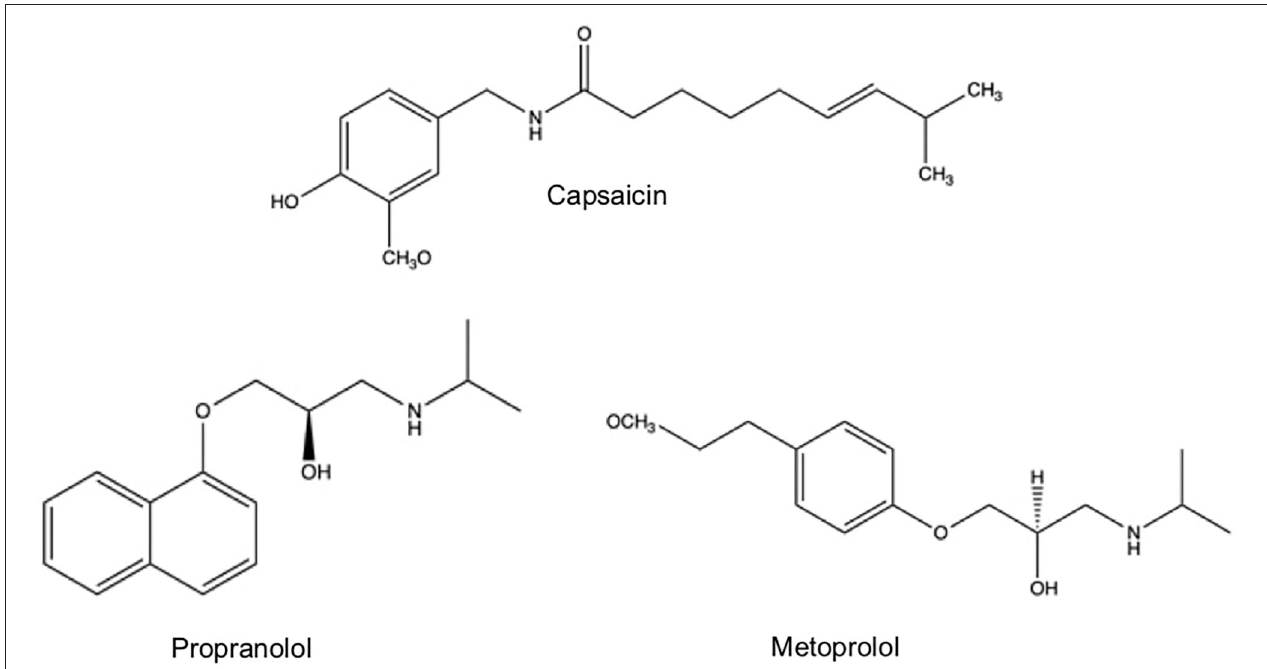
FIGURE 3 | Chemical structure of capsaicin and β -adrenergic blockers: propranolol and